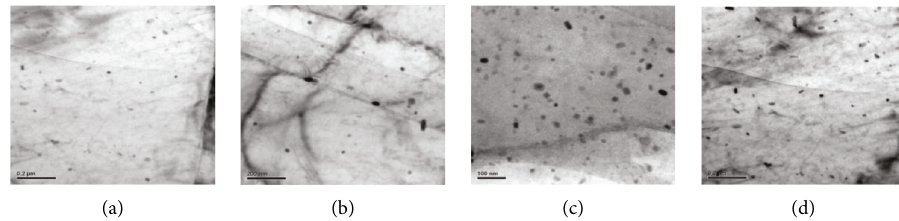
Figure 11: TEM micrographs (size distribution of the precipitates). (a) Base metal. (b) CCGTAW. (c) PCGTAW. (d)